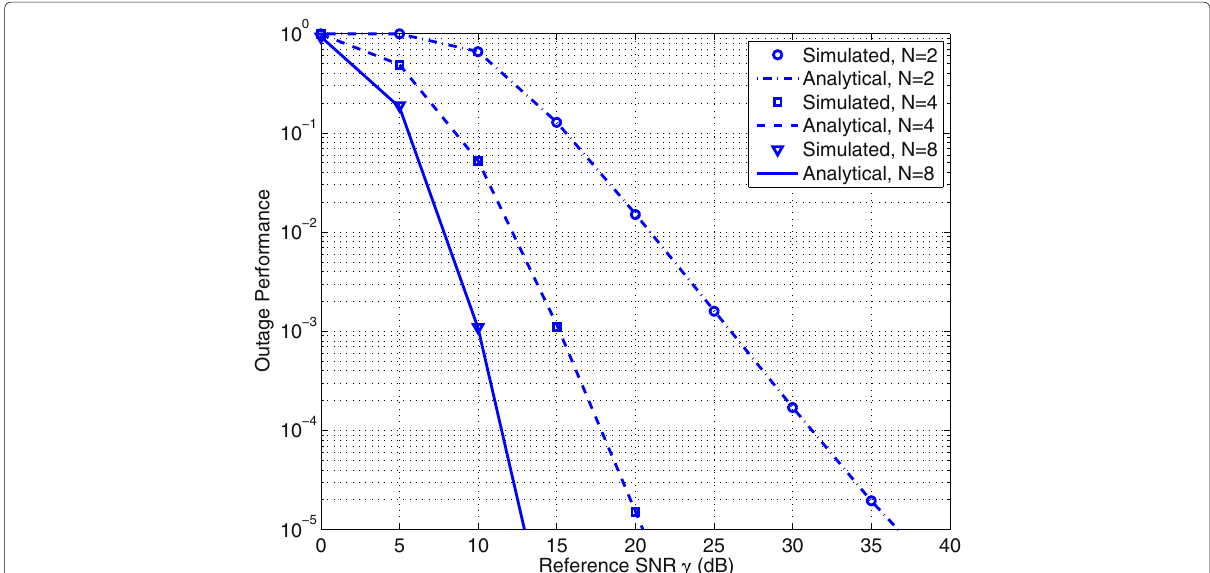
Fig. 4 Outage probability for systems with different number of antennas ( f D T s = 0.01 and x =